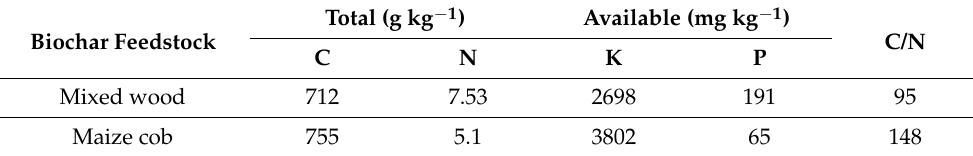
Table 1. Biochar